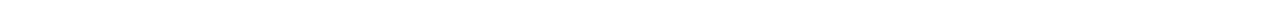
Fig. 7 Identi fi cation of ubiquitylated lysines on the C. subterraneum modi fi er protein and structural comparisons of the C. subterraneum and H. sapiens ubiquitins. a MS/MS spectra of ubiquitylated C. subterraneum ubiquitin peptides identi fi ed in the following the ubiquitylation of S. solfataricus Rad50. (2+) indicates doubly charged precursor ions. Spectra show the annotated peaks that are due to C-terminal y (coloured red) and N-terminal b (coloured blue) fragment ions. In each case, the m/z values of the precursor ions and the m/z values of the fragment ions are consistent with the underlined lysine residues modi fi ed with the ‘ TVGG ’ moiety generated following trypsin digestion. b Amino acid sequence of C. subterraneum ubiquitin indicating the three ubiquitylated lysine residues identi fi ed by the MS/MS data. c Solution (NMR) structure of the C. subterraneum ubiquitin protein (PDB: 2QMJ) with the modi fi ed lysine residues shown as sticks (in purple). d Structural superposition of the crystal structure of H. sapiens ubiquitin in wheat (PDB: 1UBQ) and the NMR structure of the C. subterraneum ubiquitin protein in blue (PDB: 2QMJ). (left) C. subterraneum modi fi ed lysines K4, K53, K68 (and an unmodi fi ed but conserved K48 residue) shown in purple, with H. sapiens conserved lysine residues K6, K48 and K63 displayed in green. (right) View looking onto α -helix 1 showing the C. subterraneum residues K29 and K33 (purple), which occupy positions on the α – helix structurally reminiscent of the K31 and K36 residues observed in the human ubiquitin molecule (green). e Multiple sequence alignments of the C. subterraneum ubiquitin protein amino-acid sequences with eukaryotic and archaeal homologues: Homo sapiens [B isoform CRA_c], Entamoeba histolytica , Meloidogyne javanica , Homo sapiens , Odinarcheota LCB4_14240, Caldiarchaeum subterraneum, Heimdallarcheota C3_02740, Heimdallarcheota C2_17770, Heimdallarcheota AB125_14240. Secondary structural features are indicated above the alignments. Black circles indicate conserved lysines in the eukaryotic proteins, while purple circles denote the C. subterraneum lysines displayed in (7c, 7d and 7e). The I44 and T46 residues are also highlighted. f Surface views of the C. subterraneum and H. sapiens ubiquitins, showing the similar exposed hydrophobic patches (red), centred on the human I44 residue and equivalent T46 residue (yellow) in C. subterraneum . Surface exposed lysines residues are displayed in